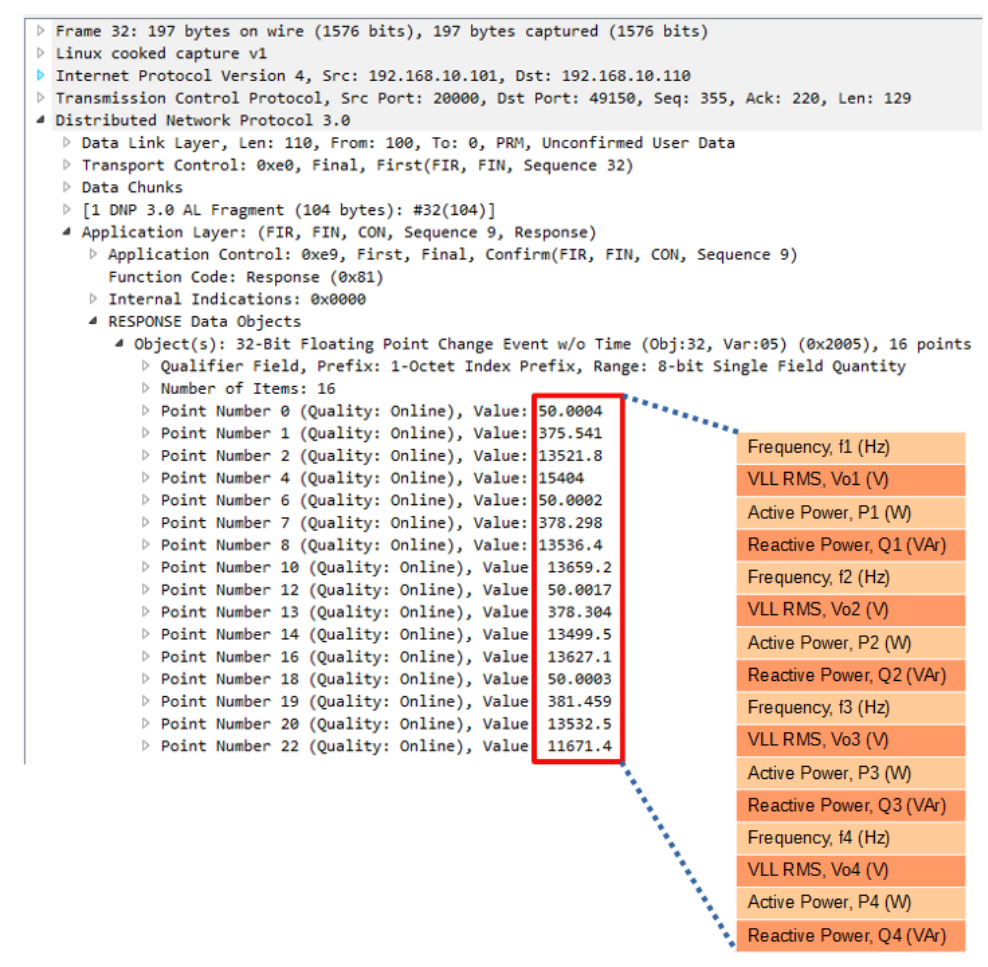
Figure 13. Data communicated over DNP3 on